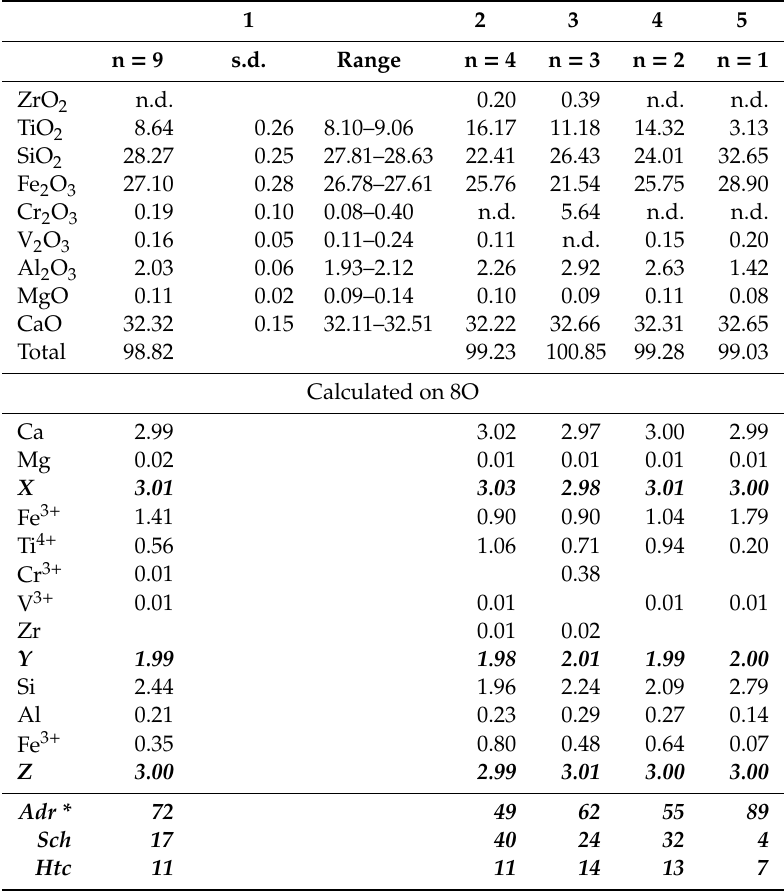
Table 7. Chemical composition of garnet from Gurim Anticline (1,2) and Zuk Tamrur (3–5),